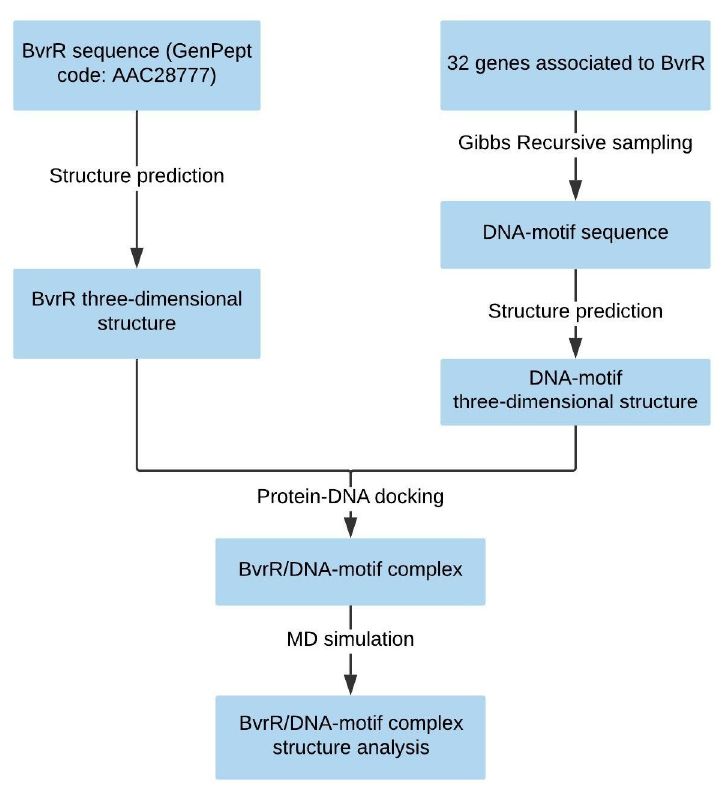
Figure 1. Work diagram of the prediction of BvrR/DNA motif interaction.